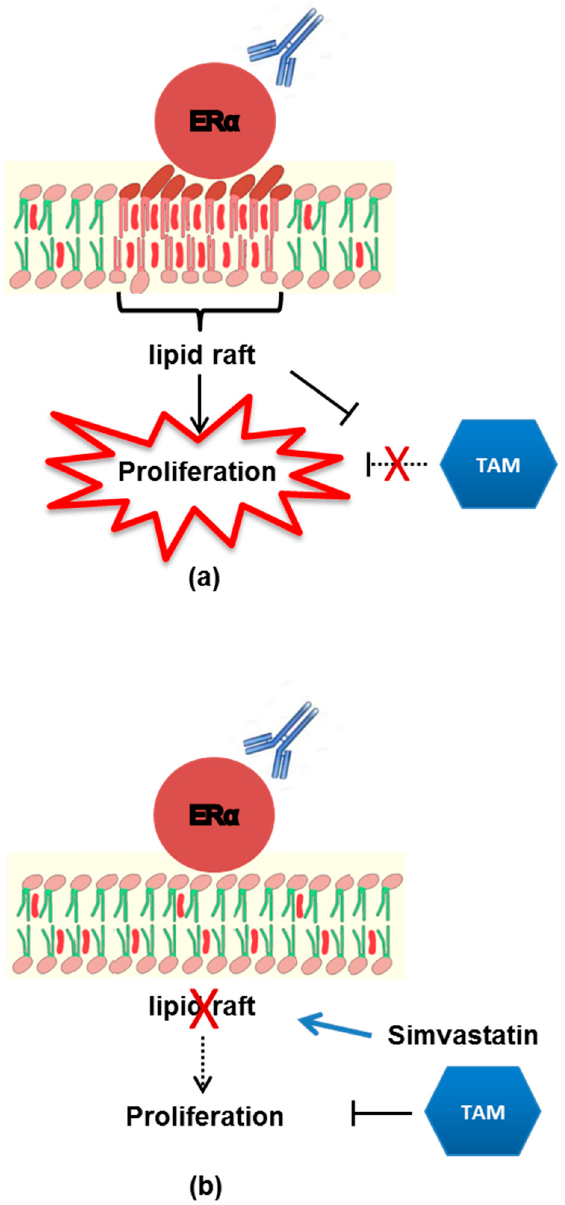
Figure 5. A model showing the effect of anti-ER α Abs on MCF-7 cells. ( a ) Anti-ER α Abs bind to and activate membrane ERalpha inducing MCF-7 cell proliferation. The “anti-ER α Abs–membrane ER” mediated signaling acts as a negative-regulatory factor of the tamoxifen-induced inhibition of cell growth. ( b ) Since membrane ERalpha is embedded in lipid rafts, the disaggregation of these rafts by simvastatin hampers the “anti-ER α Abs–membrane ER” mediated signaling, blocks anti-ER α Abs-mediated cell proliferation and restores tamoxifen inhibition.